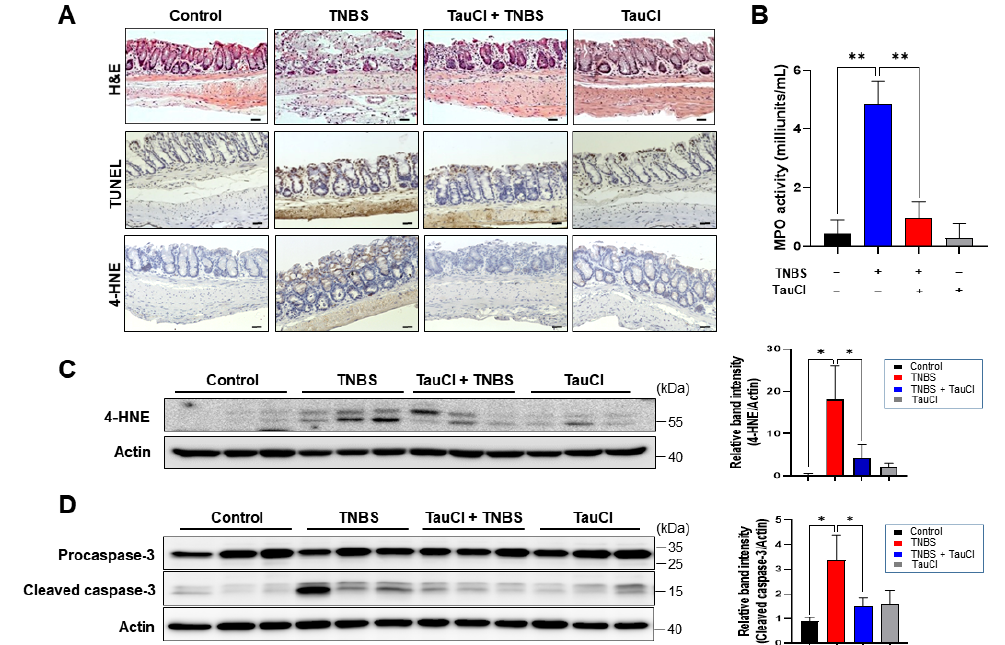
Figure 1. Effects of TauCl on inflammatory damage in the colon of TNBS-treated mice. ( A ) TauCl (20 mg/kg) was given on daily basis by gavage for 10 days before and for 3 days after intrarectal administration of 2.5% TNBS in EtOH. The comparison of body weight change ( B ), DAI ( C ), and colon length ( D ). Data are expressed as means ± SD ( n = 3 for each group). * , ** , *** Significantly different between groups compared (* p < 0.05; ** p < 0.01; *** p < 0.001).